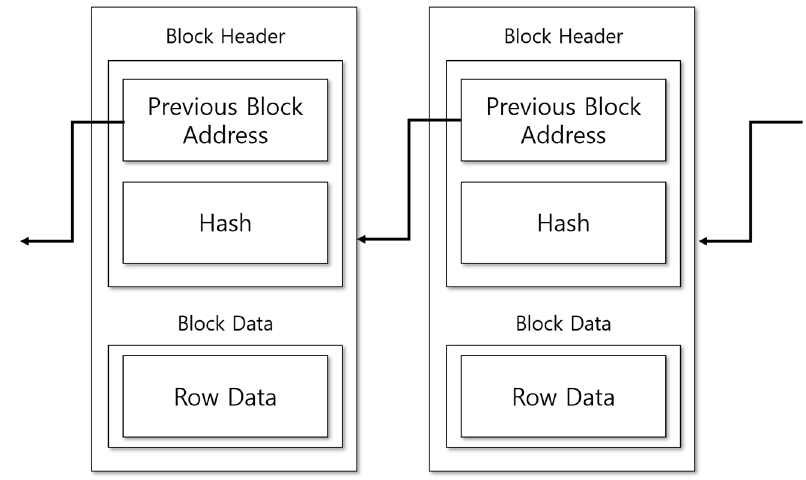
Figure 3. Proposed block configuration.